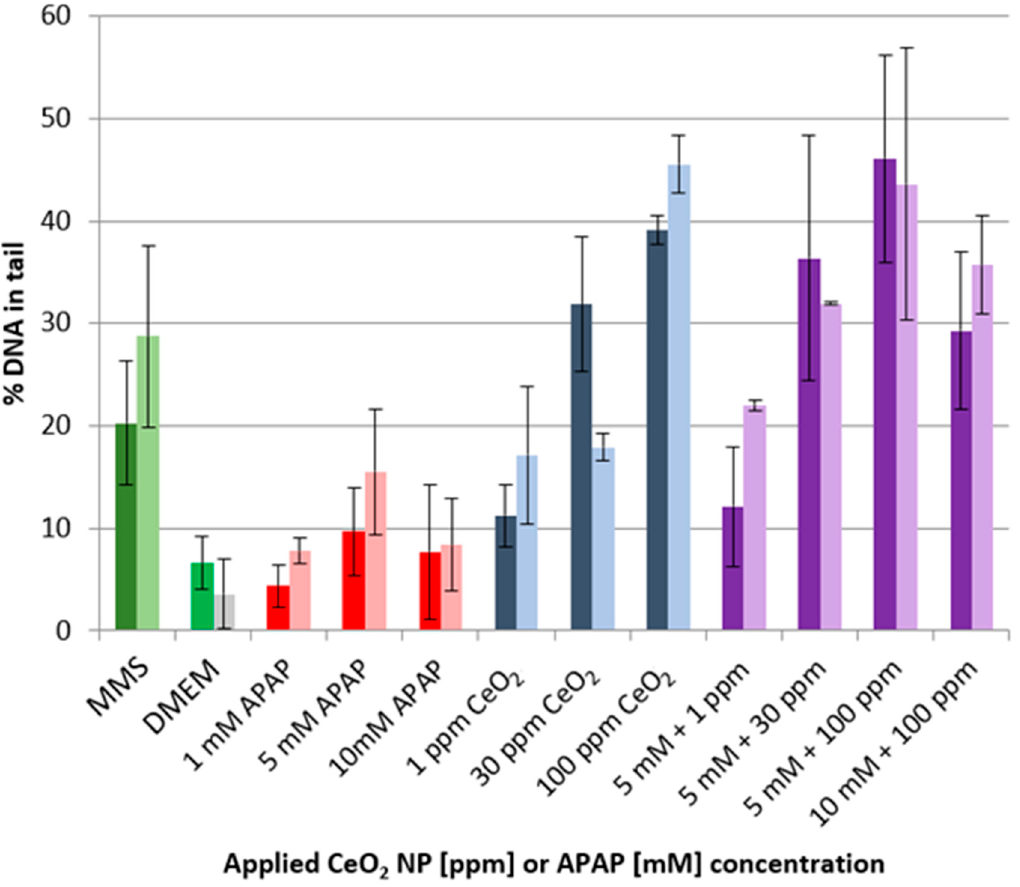
Figure 5. Alkaline Comet assay results with methyl methanesulfonate (MMS) and DMEM as positive and negative control, respectively. DNA damage was quantified as percentage of DNA in the comet tail after 24 (dark colors) and 48 h (light colors), n = 2.